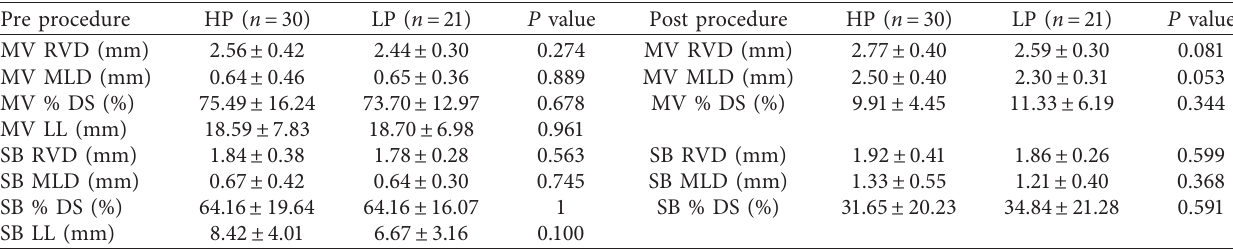
Table 4: QCA analysis of targeted lesions in the initial and final angiography.